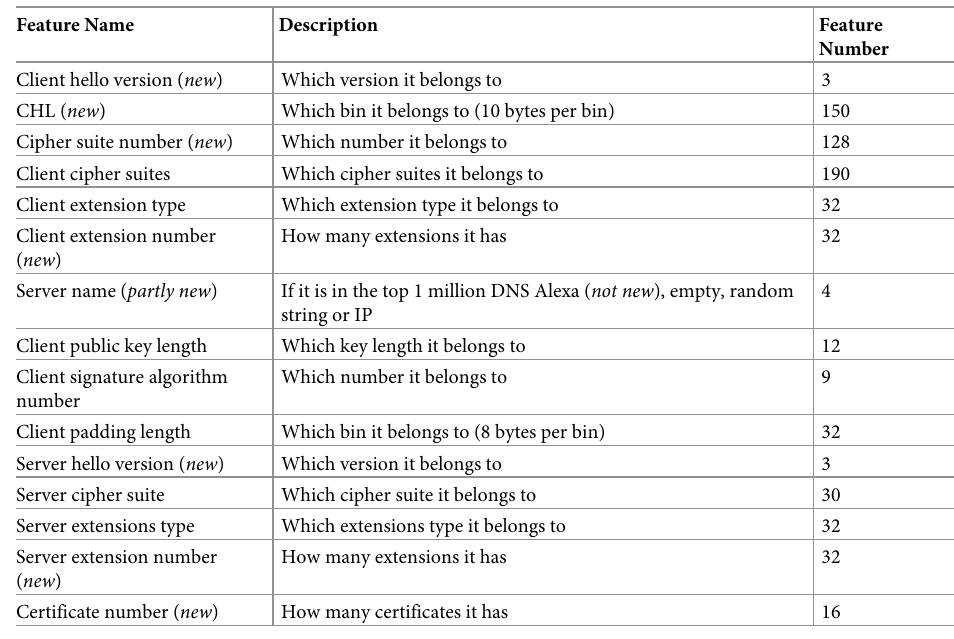
Table 1. TLS handshake feature